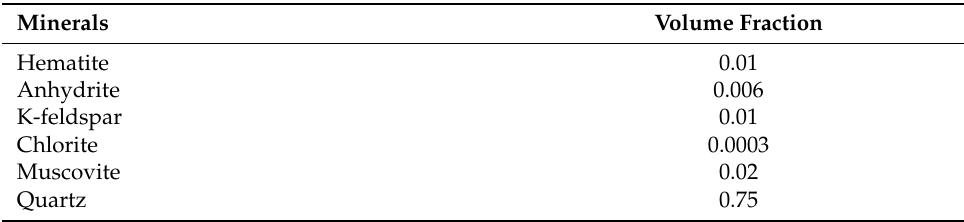
Table 3. Initial mineral volume fractions of the sandstone layer.